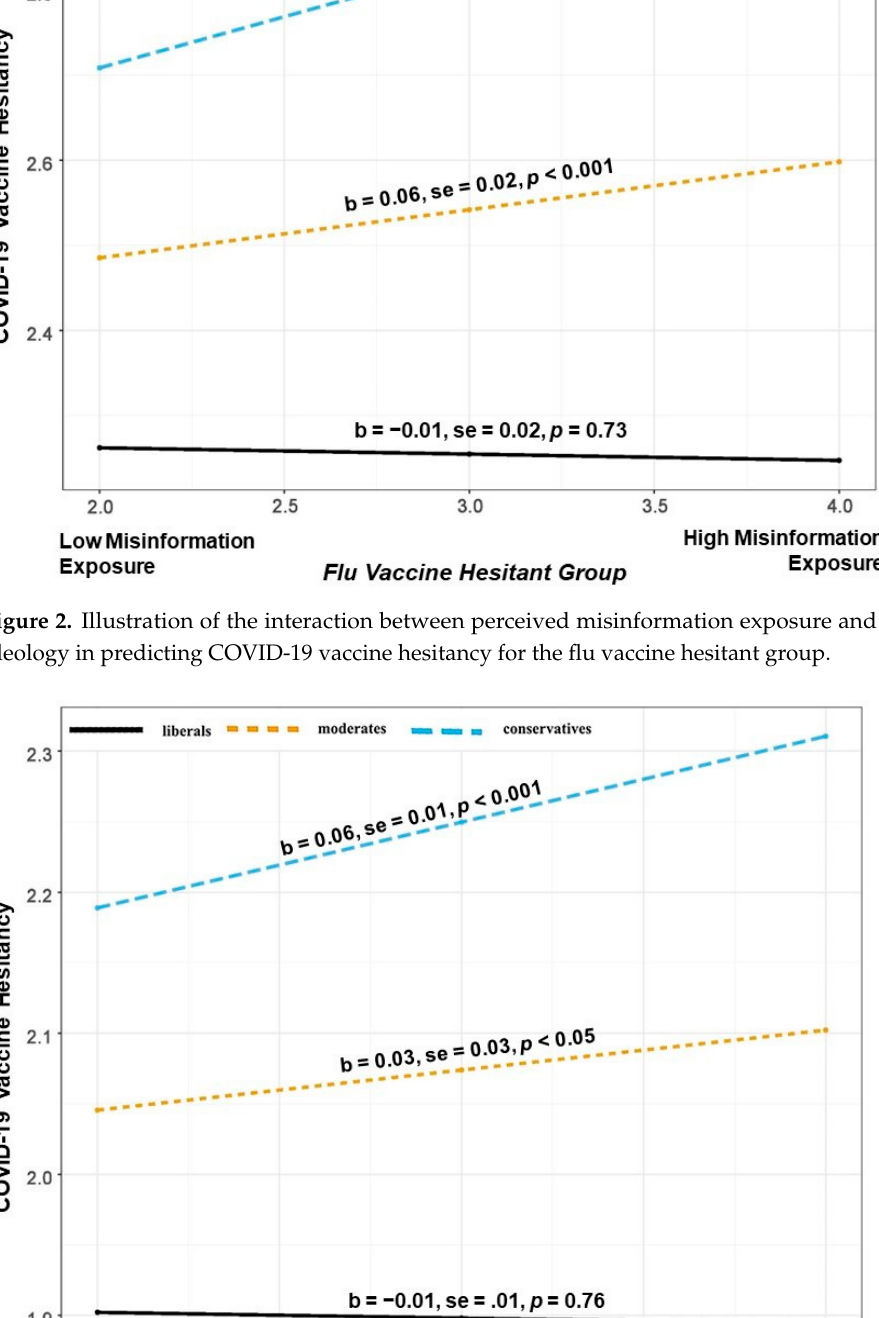
Figure 4. Illustration of the interaction between perceived misinformation exposure and political ideology in predicting COVID-19 vaccine hesitancy for the flu vaccine regular group.